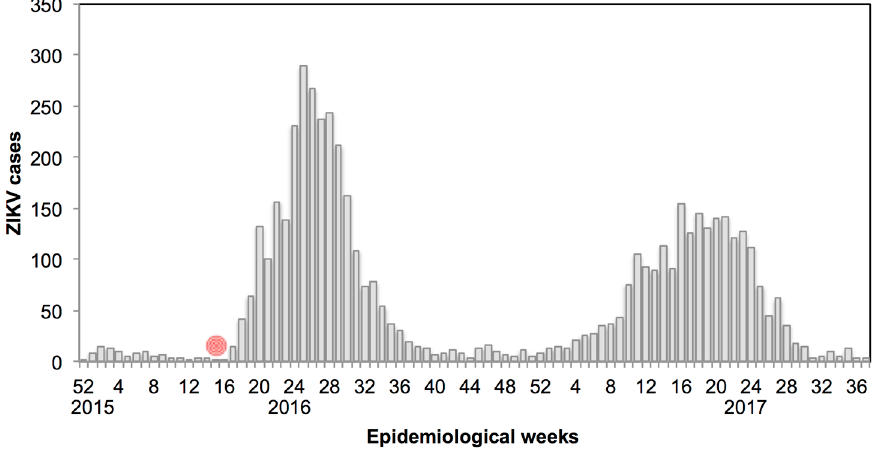
Figure 2. Weekly ZIKV cases in Ecuador through epidemiological week (EW) 38 in 2017. The date of the earthquake (EW 15, 2016) shown in red. In 2016, 85.1% of ZIKV cases depicted here (2510 of 2944 cases) were reported from Manabí Province, the location of this study. Data provided by the Ministry of Health of Ecuador [4].